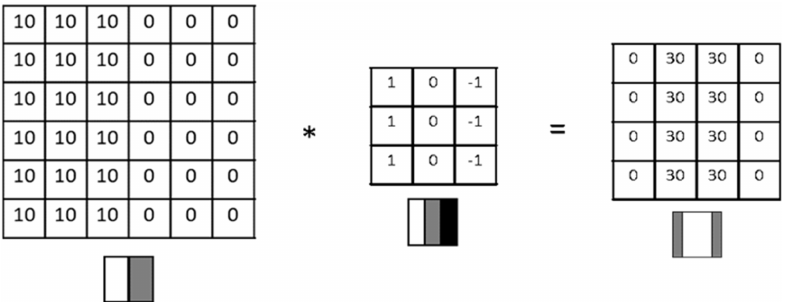
Figure 4. Edge Detection Using Convolution.